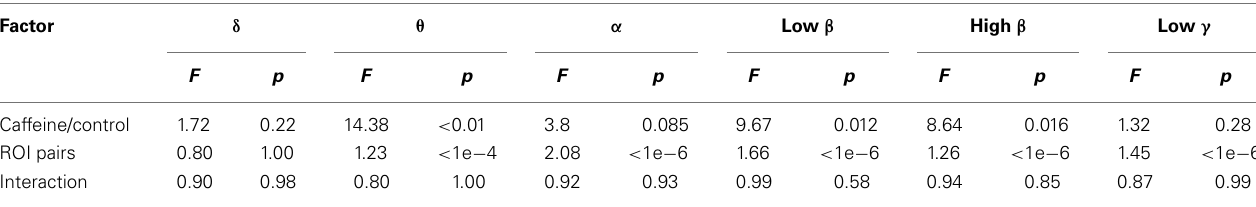
Table 2 | Quantitative assessment of the group data for each of the six MEG frequency bands of interest (eyes closed condition) using repeated measures two-way analysis of variance (ANOVA) to examine the effects of (1) caffeine/control and (2) ROI pair on the measured connectivity